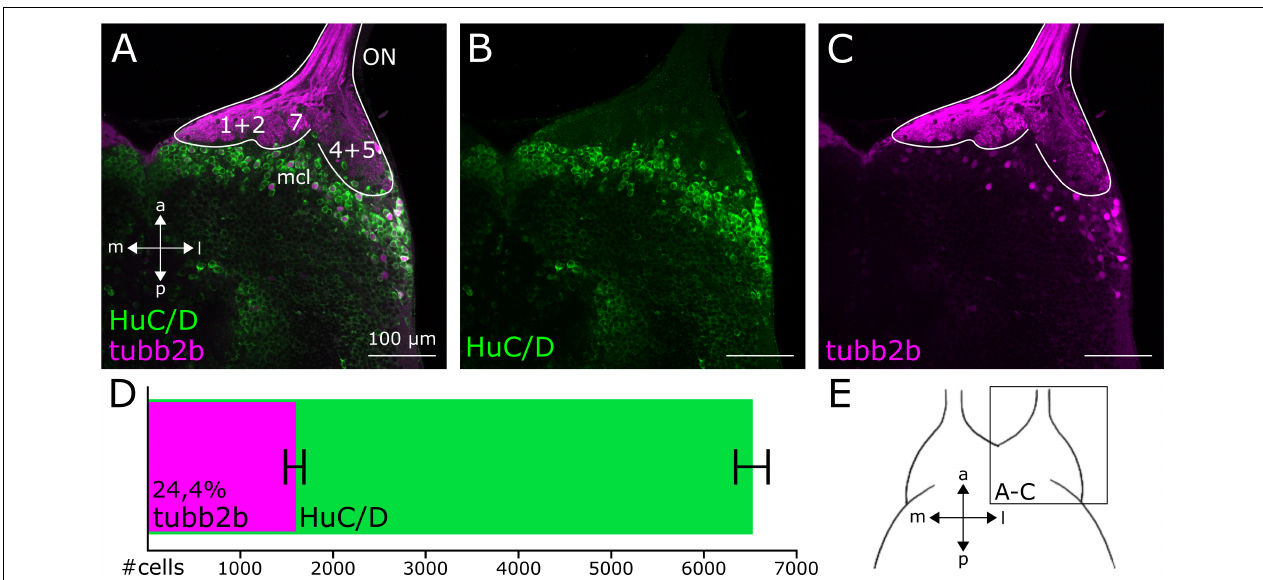
FIGURE 3 | Cell density of tubb2b -positive neurons in the OB of premetamorphic Xenopus larvae. (A–C) Ventral view of a single focal plane of the OB of one brain hemisphere. (A) HuC/D-positive cells (green) are present throughout the whole OB. Few HuC/D-positive cells are also tubb2b -positive (magenta). (B) Pattern of HuC/D-positive cells within the OB. (C) tubb2b -positive cells are located in the mitral cell layer (mcl) of the OB. (D) Number of tubb2b -positive cells in comparison to HuC/D-positive cells of the whole OB. Average number of tubb2b -positive cells: 1,588 ± 191 ( n = 10). Average number of HuC/D-positive cells: 6,517 ± 210 ( n = 3). Cell density of tubb2b -positive cells compared to HuC/D-positive cells: 24,4%. (E) Scheme of the ventral OB showing the position of the images (A–C) . ON, olfactory nerve; a, anterior; p, posterior; m, medial; l,